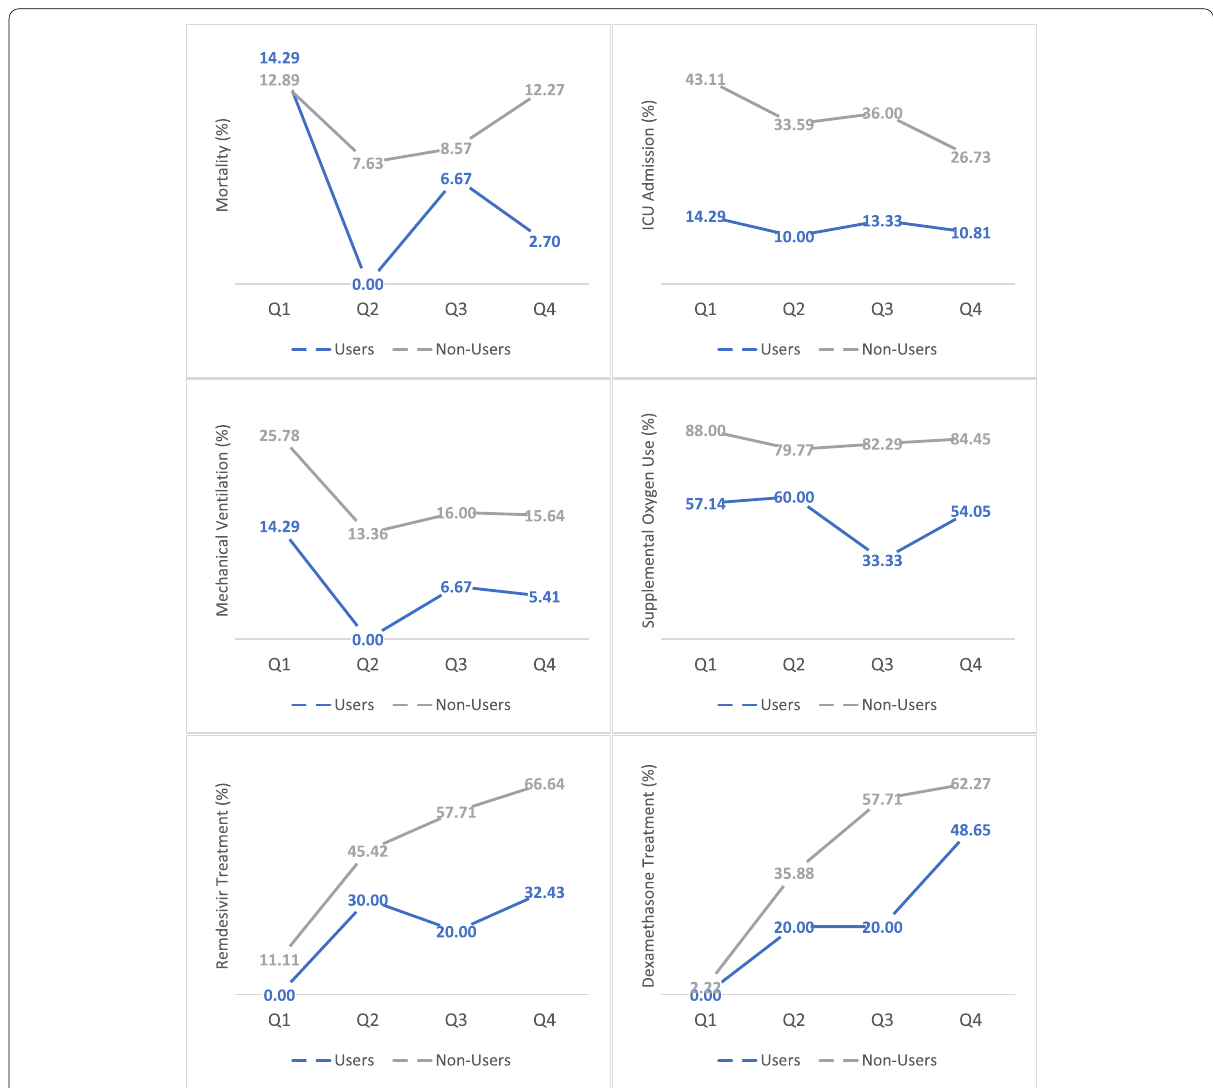
Fig. 1 Outcomes and treatment in COVID patients stratified by admission date. Outcomes varied throughout the pandemic due to COVID surges. Cannabis users consistently had less severe disease course. Percentages displayed are the proportion of patients with admission dates within